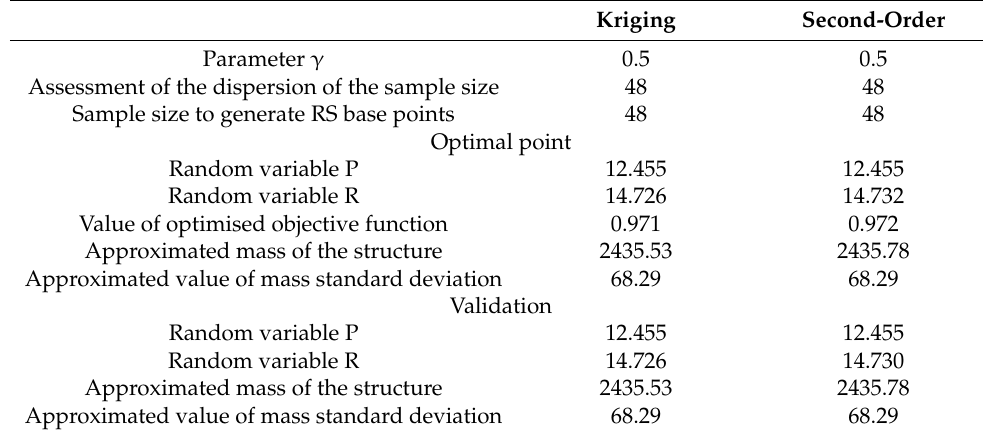
Table 9. Comparison of the results of kriging and the second-order